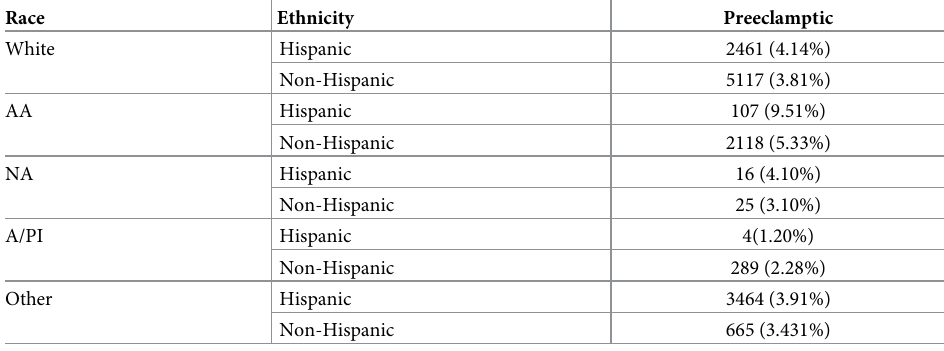
Table 4. Distribution of preeclamptic patients among different race (AA: African American, NA: Native America, A/PI: Asian or Pacific Islander), and ethnic (Hispanic and non-Hispanic) groups in the Texas